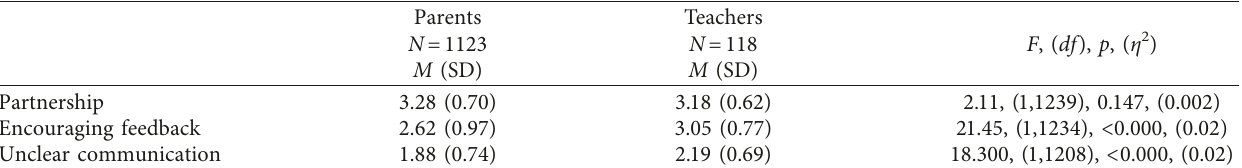
Table 3: Descriptive statistics and ANOVA results for partnership, encouraging feedback, and unclear communication among parents and teachers (scale